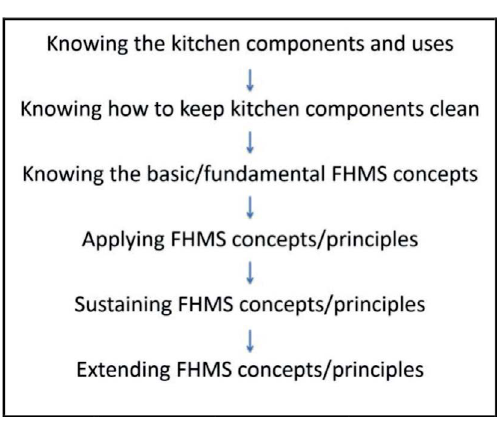
Fig. 2. Human participation pathway to utilize food hygiene microbiological safety (FHMS) concepts/ principles in domestic/ household